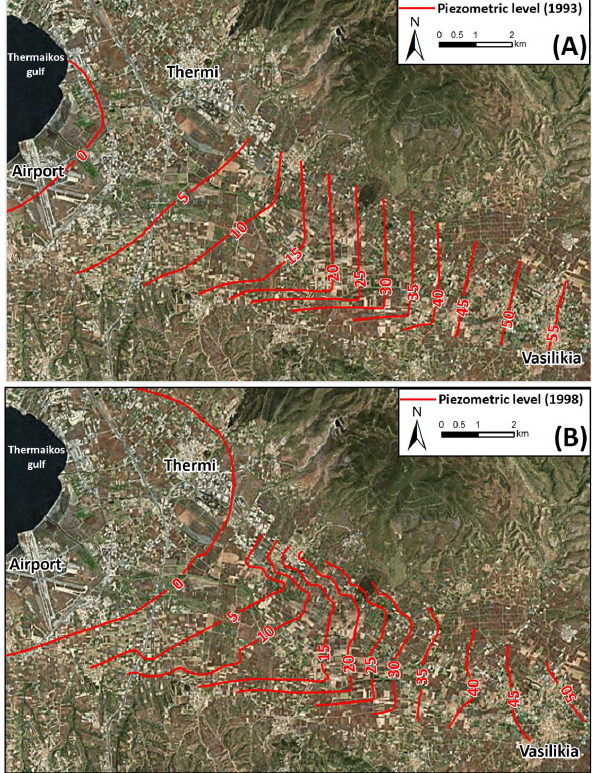
Figure 2. Isopiezometric curves of the deep semi-confined aquifers system of the area within the brown inset of Figure 1. May 1993 (A) and May 1998 (B). Data from Nagoulis & Loupasakis, 2001.